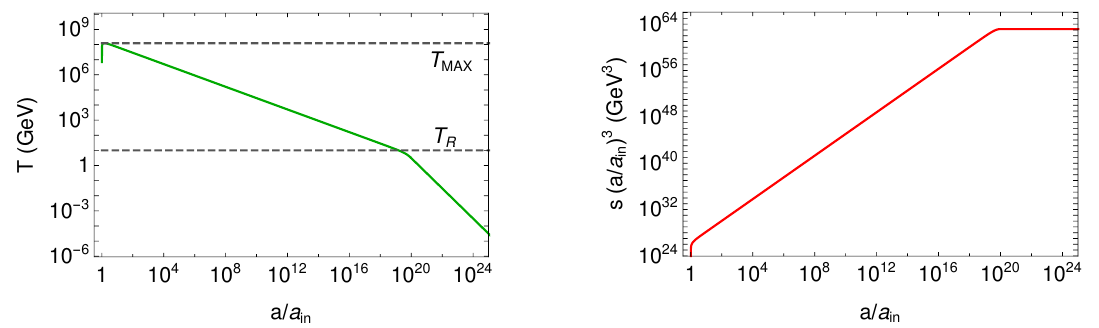
Figure 4. Radiation bath temperature (left) and the entropy in a comoving volume (right) as a function of the scale factor. We set E